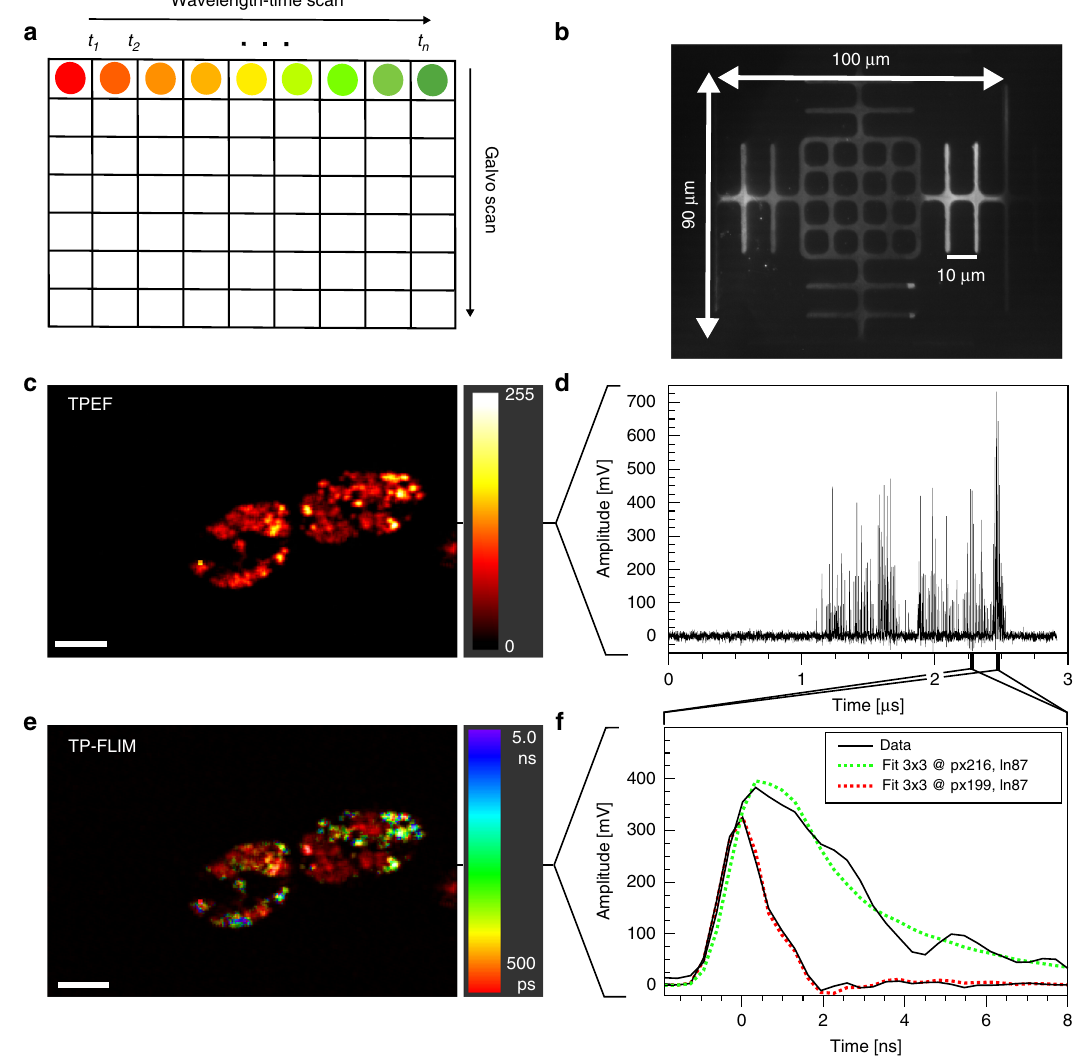
Fig. 3 SLIDE high-speed dual-modailty imaging at 2000 frames per second. a In SLIDE microscopy, the x -axis is scanned by spectro-temporal encoded diffraction scanning and the y -axis by a galvo mirror. b The fi eld-of-view (FOV) is 100 × 90 µ m 2 using the 60x objective (resolution target has 10 µ m pitch). c Two-Photon intensity image of Euglena gracilis algae cells (256 × 170 pixels). Each line is acquired within 2.9 µ s at high signal-to-noise ratio (SNR) of up to 490 (peak SNR) (cf. d ). Zooming into individual pixels ( f ) reveals different transient fl uorescent decay times which can be fi tted to extract a fl uorescence lifetime value for each pixel. Therefore, a 3 × 3 pixel binning was applied for higher lifetime fi delity. The lifetimes are colour-coded to achieve a TP-FLIM image ( e ) from the same dataset. In the TP-FLIM image the rapidly decaying auto fl uorescent chloroplasts (red) can be distinguished from the Nile Red- stained lipid droplets (green, blue). This unaveraged image was acquired at 2.012 kHz frame-rate (497 µ s recording time). The average power on the sample was 30 mW. Lifetimes were determined by deconvolution with the IRF (convolution fi t shown in f ). Photon counts for the curves in ( f ) are 82 photons (red) and 246 photons (green). Scale bar represents 10 µ